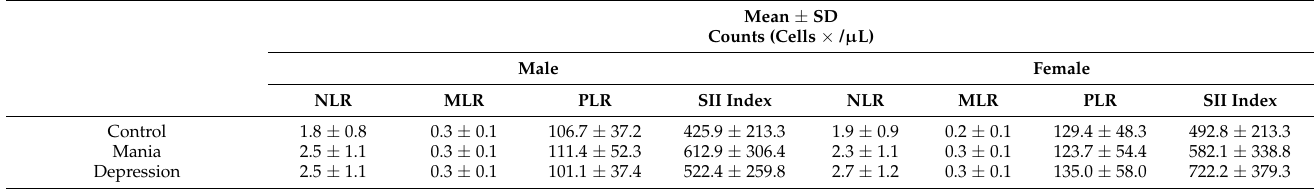
Table 5. Inflammatory ratios: neutrophil-to-lymphocyte (NLR), monocyte-to-lymphocyte (MLR), platelet-to-lymphocyte (PLR) and systemic immune-inflammatory (SII) index in male and female patients with mania or depression and healthy controls. Values are presented as mean ±